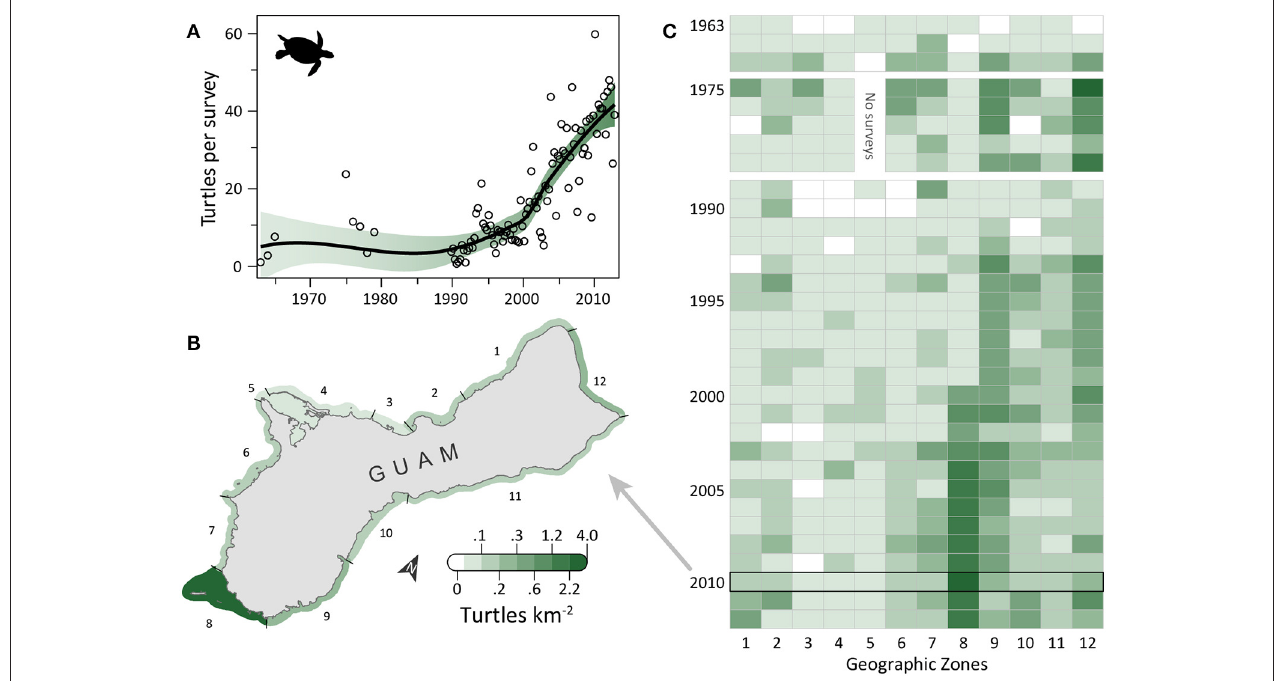
FIGURE 1 | Eight-fold increase in observed sea turtles on Guam’s reefs in the last five decades. (A) Trend in turtle observations from semimonthly aerial surveys conducted by Guam Division of Aquatic and Wildlife Resources (DAWR). Open circles are annual or quarterly observations (turtles) per survey (OPS). Smoothed line is a model fit, with 95% confidence interval shaded. Mean population growth rate (PGR) was 0.07 ( SD = 0.06, CV = 90%) since 1963 and 0.10 ( SD = 0.04, CV = 37%) since 1989. (B) Map of 12 geographic survey zones; shading depicts observed densities for 2010, when annual OPS was highest. (C) Trends in densities for the 12 zones. Zone 5 was closed to surveys in 1975–1979 due to military restrictions. The west coast (zones 1–7) generally had lower densities than the rest of Guam after the 1970s. The increase in zone 8 drives the overall increase observed in (A) .